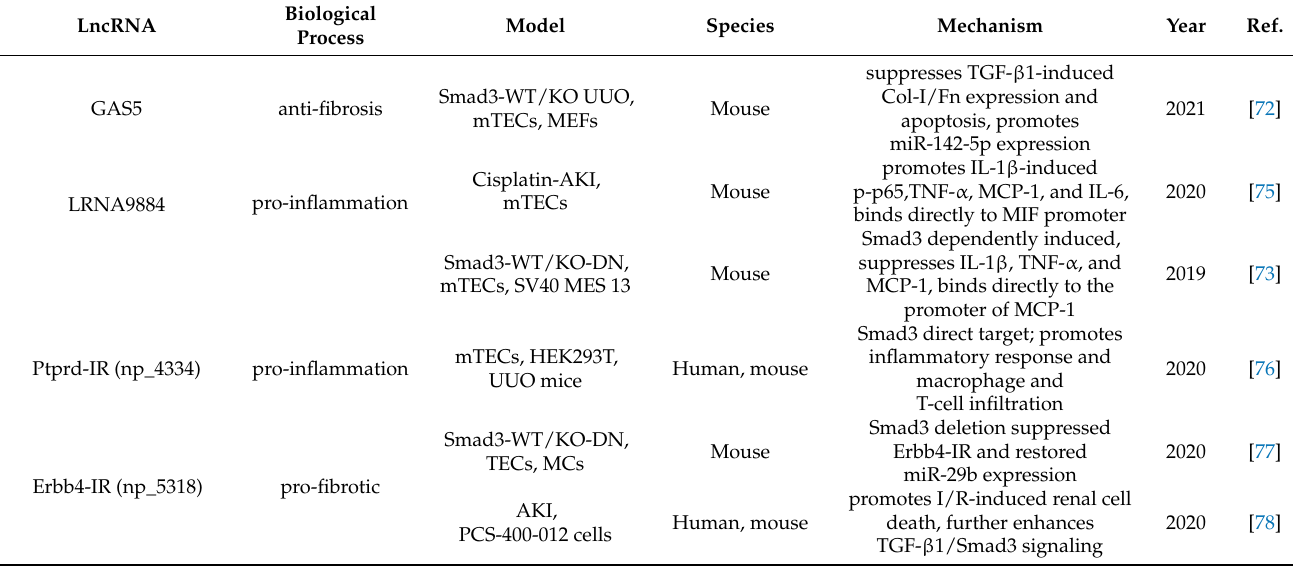
Table 2. The Smad3-associated lncRNAs in renal